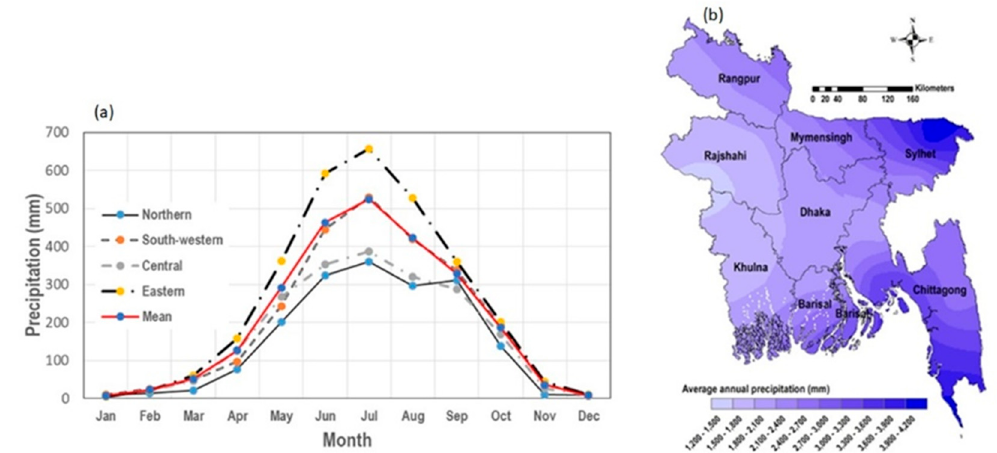
Figure 3. ( a ) Monthly distribution of rainfall four different regions of Bangladesh and. ( b ) Spatial distribution of rainfall from 1980 to 2015.